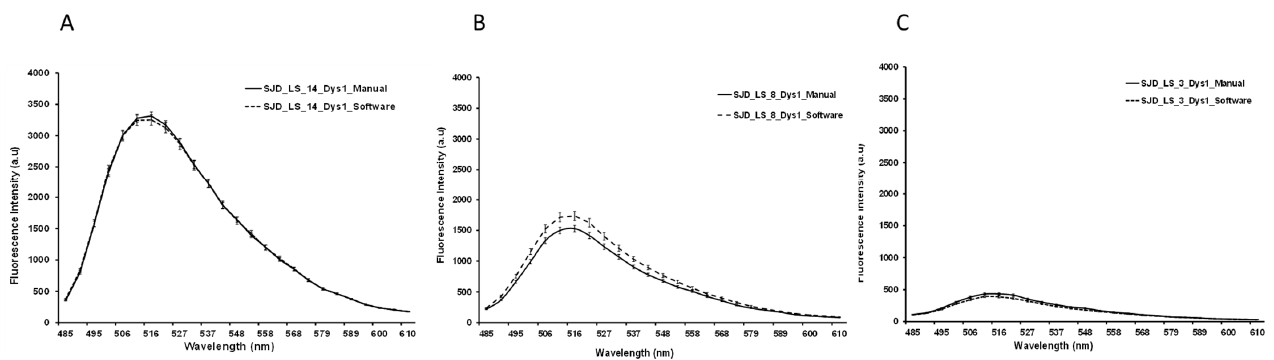
Figure 4. Graphics representing the mean fluorescence intensity spectral of NCL-Dys1 ( y -axis) and emission wavelength ( x -axis) at 470 nm excitation wavelength. Representative examples of the comparison between manual (solid line) and automatic quantification (dotted line). Healthy control ( A ). BMD ( B ). DMD ( C ). Results showed no significant differences.